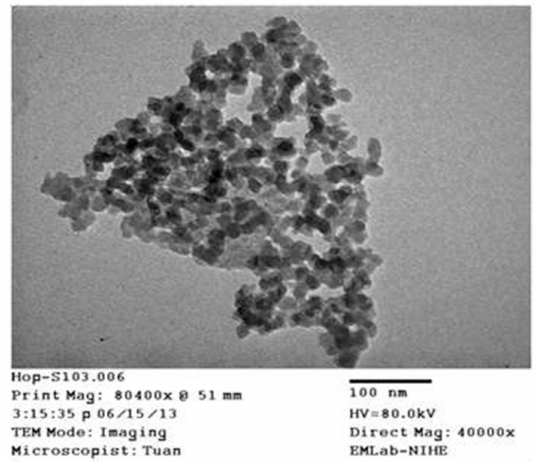
Figure 4. TEM of nanosilica.